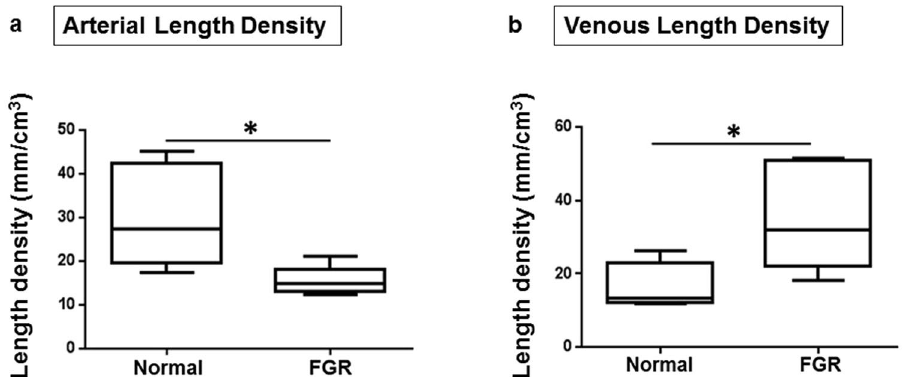
Figure 5. Arteries are shorter and veins are longer than normal in FGR casts. Panels a and b represent (a) the arterial length density and (b) venous length density respectively. Compared to normal casts, arterial path was significantly shorter in FGR ( a ). However, the converse is true for the venous network ( b ). Data presented as boxplots showing the median, range and interquartile range. n = 12 normal (6 arterial, 6 venous) and 12 FGR (6 arterial, 6 venous) casts. Mann Whitney test, * marks two-tailed p vaule = 0.009 and 0.03 in a and b respectively.